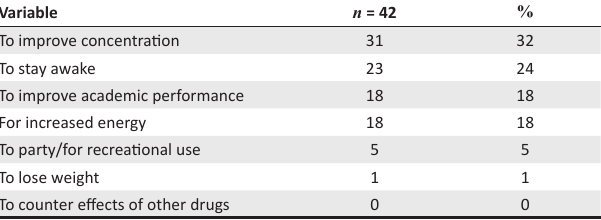
TABLE 1: Reasons for use of stimulants.